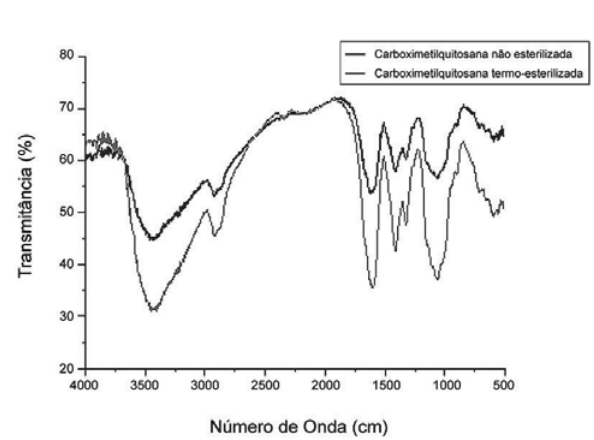
Fig. 3 - Espectroscopia no infravermelho, indicando que